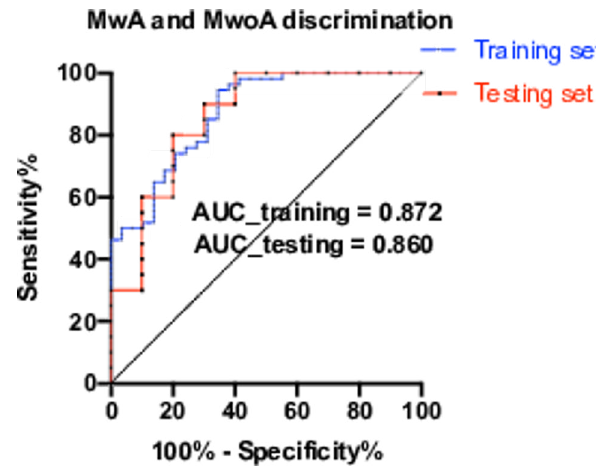
Fig. 4 ROC curves were employed to evaluate the performance of the SVM model in the training and testing sets. The accuracy and area under curve of the SVM model in the training and testing sets were 84.3% and 0.872, 83.3% and 0.860 in discriminating patients with and without aura,